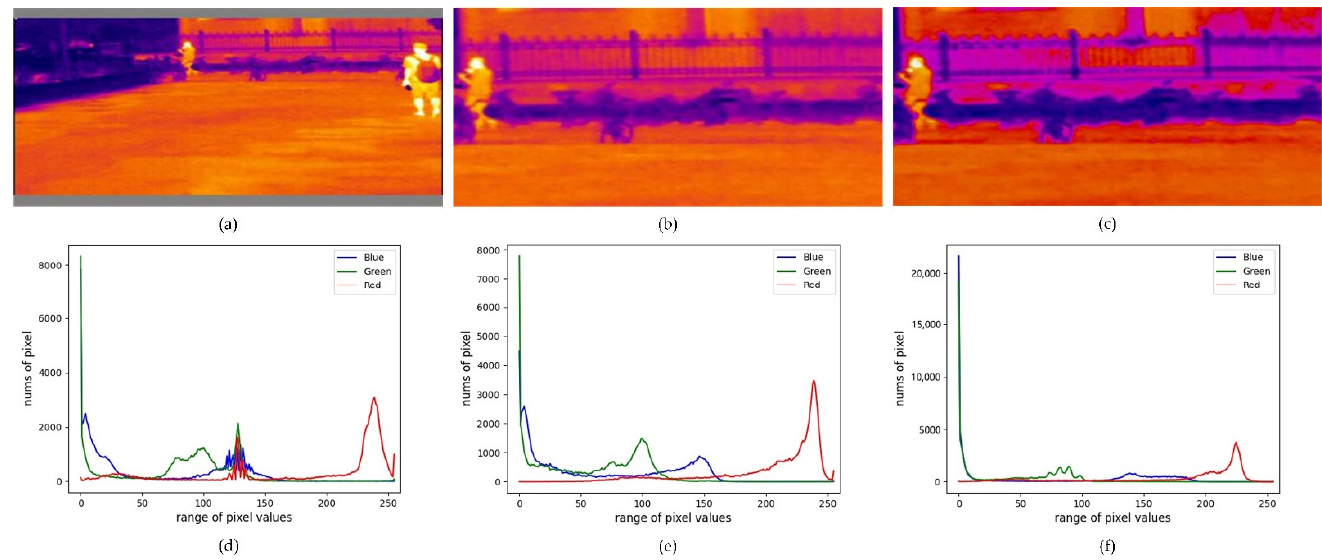
Figure 8. The result of an image being processed through the above data augmentation strategy. ( a ) The original image with gray filling; ( b ) the result of IHF and LWS; ( c ) the result of CGT-HSV, where the data dimensions of the three images are all 416 × 192 × 3; and ( d – f ) the pixel histograms of the RGB channels, which correspond to ( a – c ).